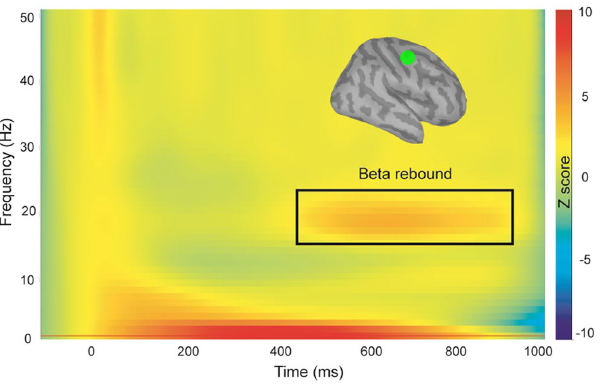
Figure 2. The grand-averaged time-frequency map of the contralateral right primary motor cortex (MI) for the frequency band of 1–50 Hz. A clear beta rebound (~20 Hz) was observed around 400–900 ms after the stimulus